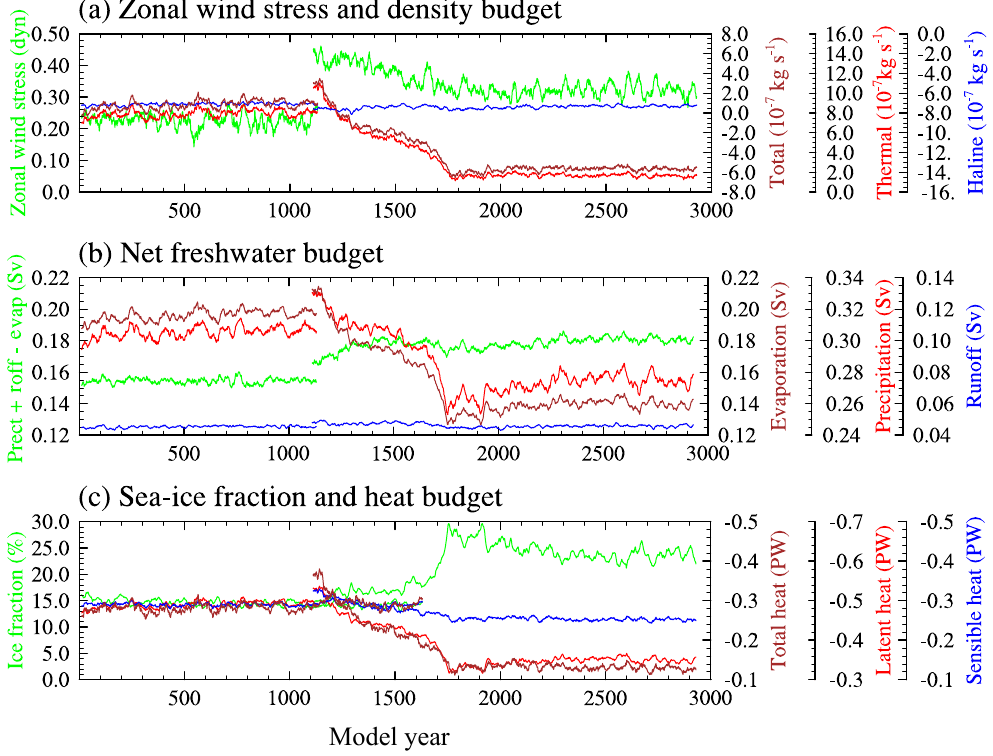
Figure 3. Regional annual mean across the North Atlantic basin at 40–70 ◦ N for MTP (1–1100 years) and NTP (1101–2940 years) of (a) zonal surface wind stress, total density flux, haline density flux, and thermal density flux (total density flux is decomposed into haline contribution due to freshwater flux and thermal contribution due to heat flux; Schmitt et al., 1989); (b) net freshwater, precipitation, runoff, and evaporation fluxes; (c) sea-ice fraction, total heat, sensible heat, and latent heat fluxes (units: PW, 1PW = 10 15 W). For comparison purposes, all lines with common units use identical vertical scale